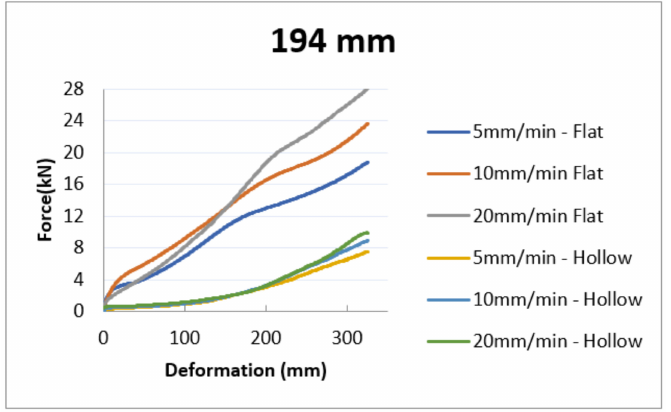
Figure 18. Deformation and force at each position for a diameter of 194 mm.